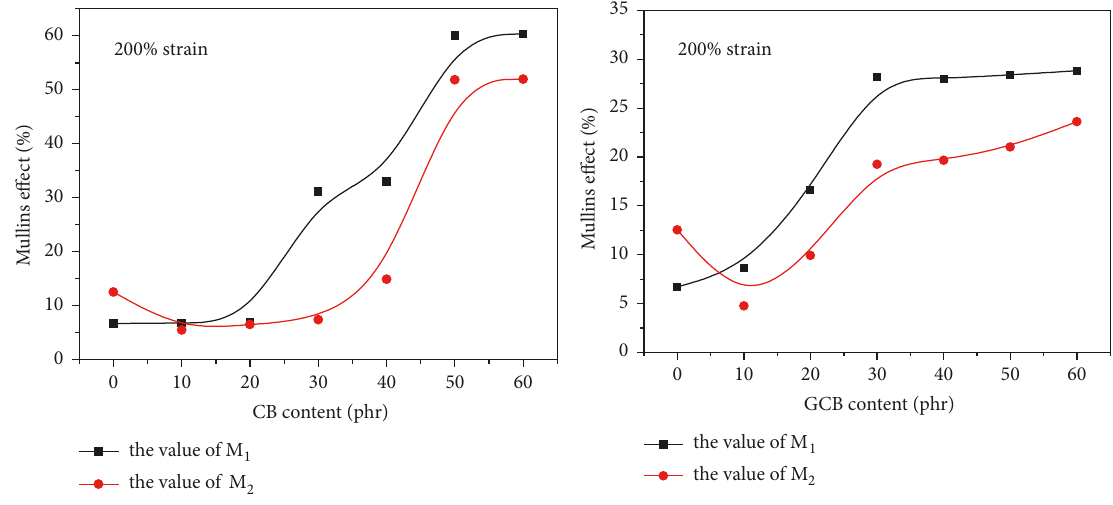
Figure 5: Effect of storage on Mullins effect of NR/CB and